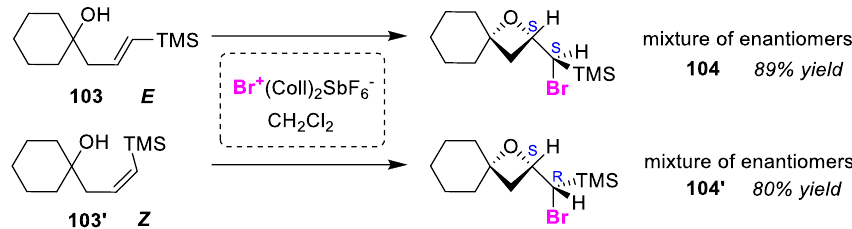
Figure 49. Stereoselective bromocycloetherification of E -silyl and Z -silyl homoallylic alcohols ( 103 and 103′ ) using Br + (Coll) 2 SbF 6 − .